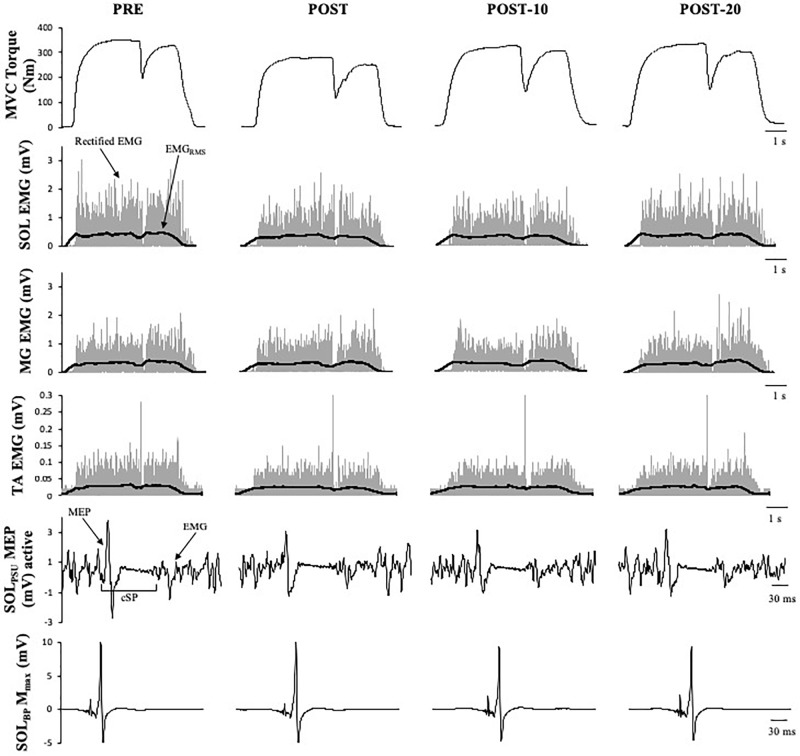
Example data obtained from one participant in the non-caffeine session of Experiment 1 before (PRE) and immediately (POST), 10 min (POST-10) and 20 min (POST-20) after the exercise protocol. Decreases in MVC torque, SOLRMS, and MEP amplitude during MVC (second row) and are noticeable immediately after the exercise protocol.